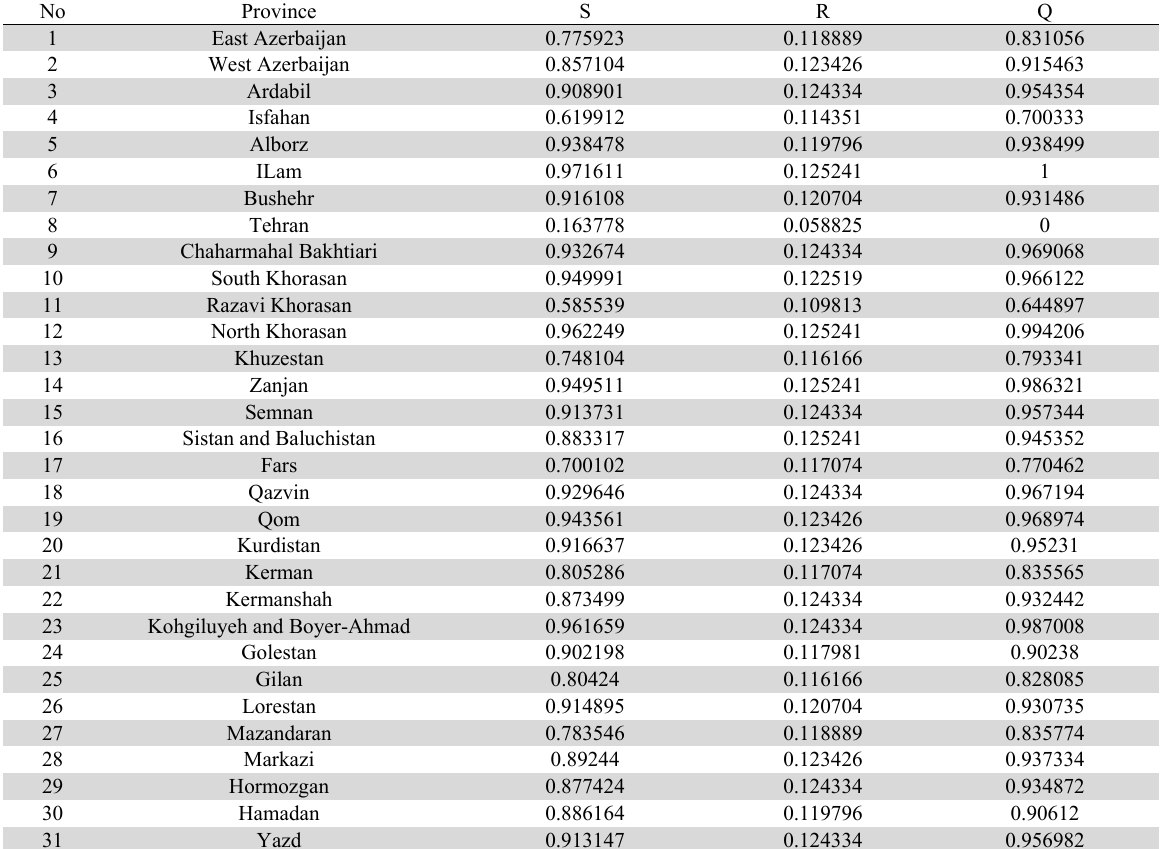
S, R and Q measures of the